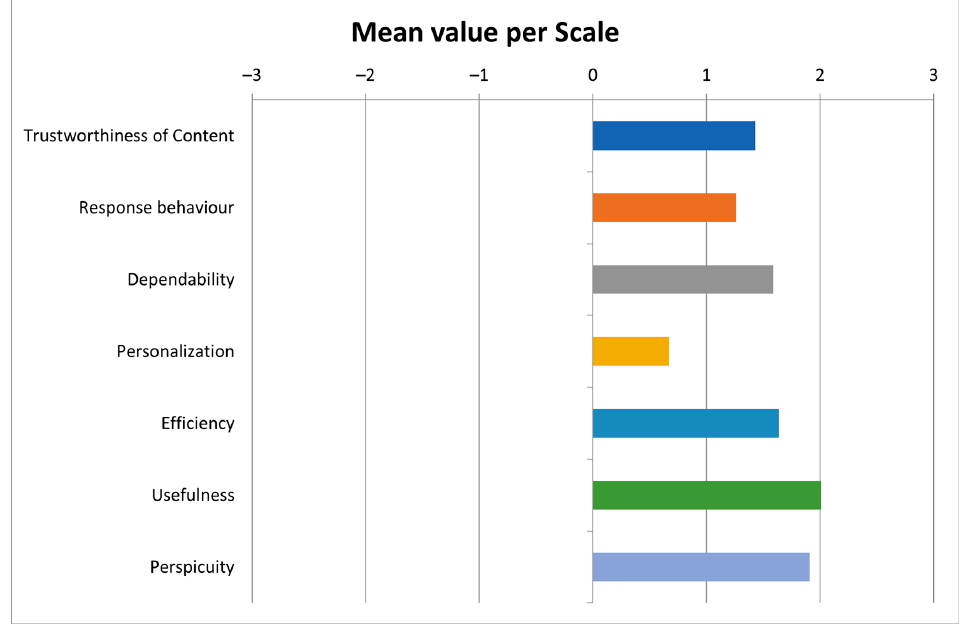
Figure 13. Mean value per scale.